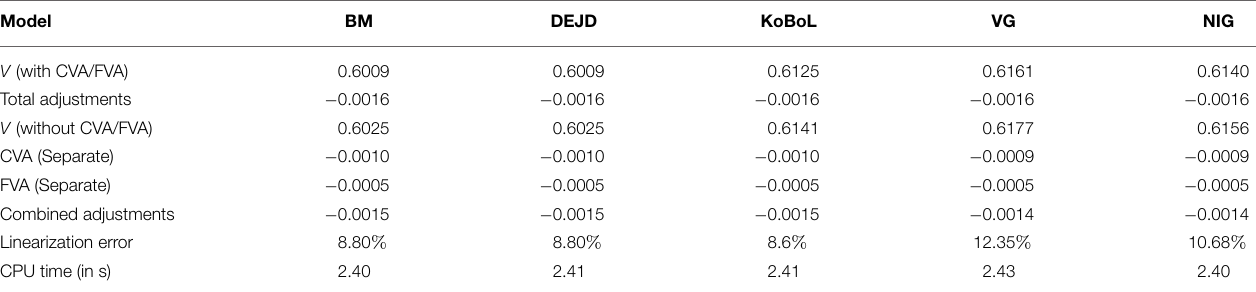
TABLE 6 | Prices of at-the-money digital put for different models as of 28 May 2015, time to maturity T = 0 . 0877 , spot S = 27 , 454 . 31 , strike K = 27 , 400 , risk-free rate r = 0 . 25 % , collateral rate r C = 1 % , funding rate r F = 1 . 7 % default intensity λ = 0 . 05 , recovery rate R B = 0 . 4 , collateral threshold H B = 500 . Model BM